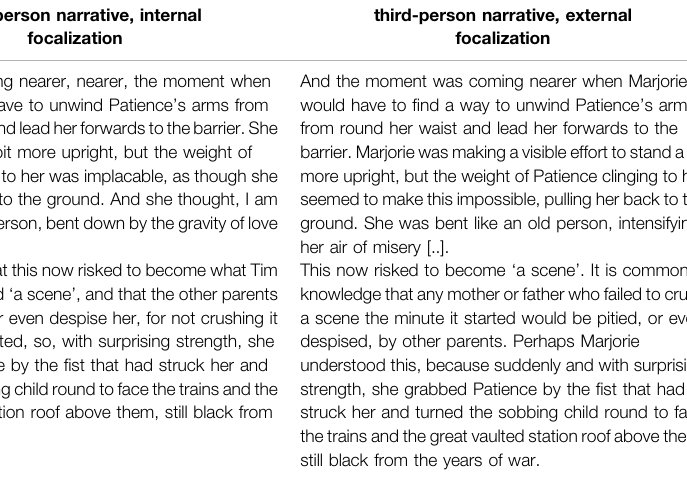
TABLE 2 | Excerpts of text stimuli of Experiment 1.